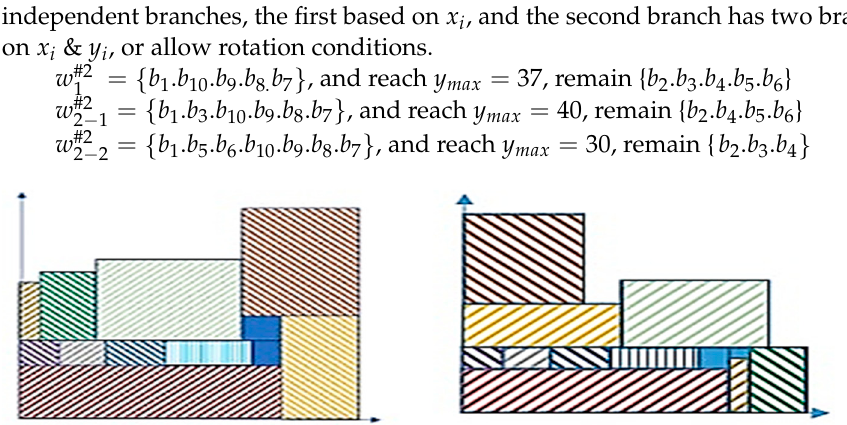
Figure 11. Continuo restoring to reduce the waste in stowage area.